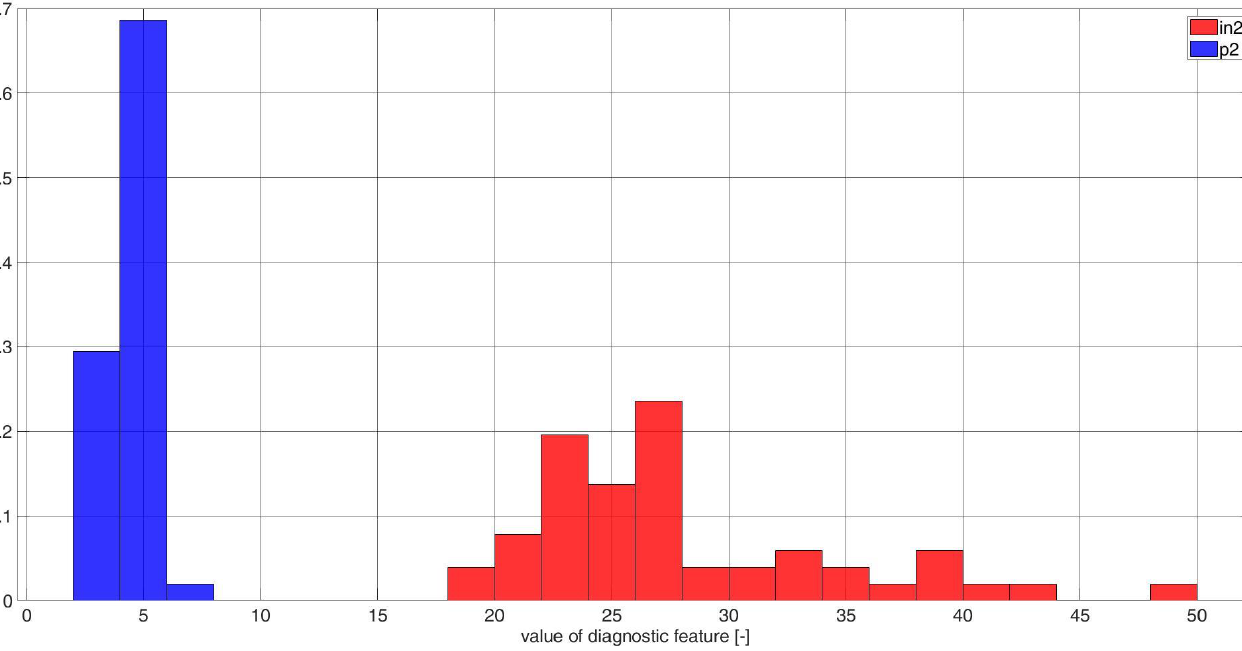
Figure A18. Histograms of diagnostic features based on the CCSM3 (correlation number is 20— Table A1) bearings in2 and p2.